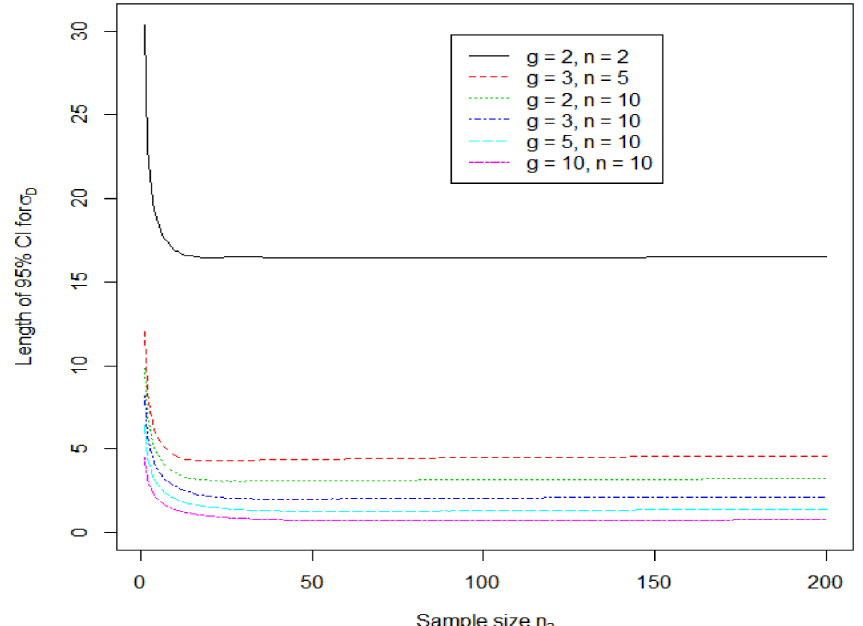
Fig. 4. Estimated lengths of 95% con fi dence intervals for s D versus sample size n 2 for six values of n 1 ( g =2, n =2 so n 1 = 4, g =3, n =5 so n 1 =15,